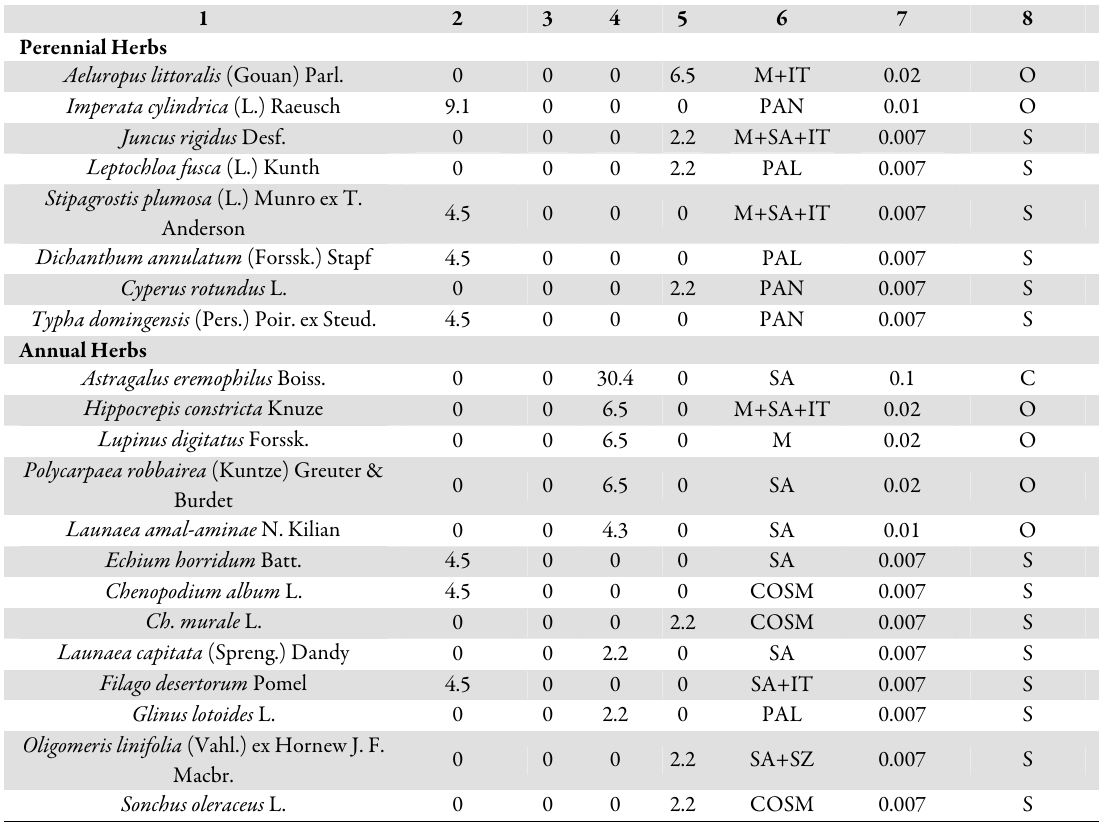
Tab. 2. Species composition of the obtained 7 vegetation groups, together with their presence values (p%). Figures in bold are the dominant species that have the highest